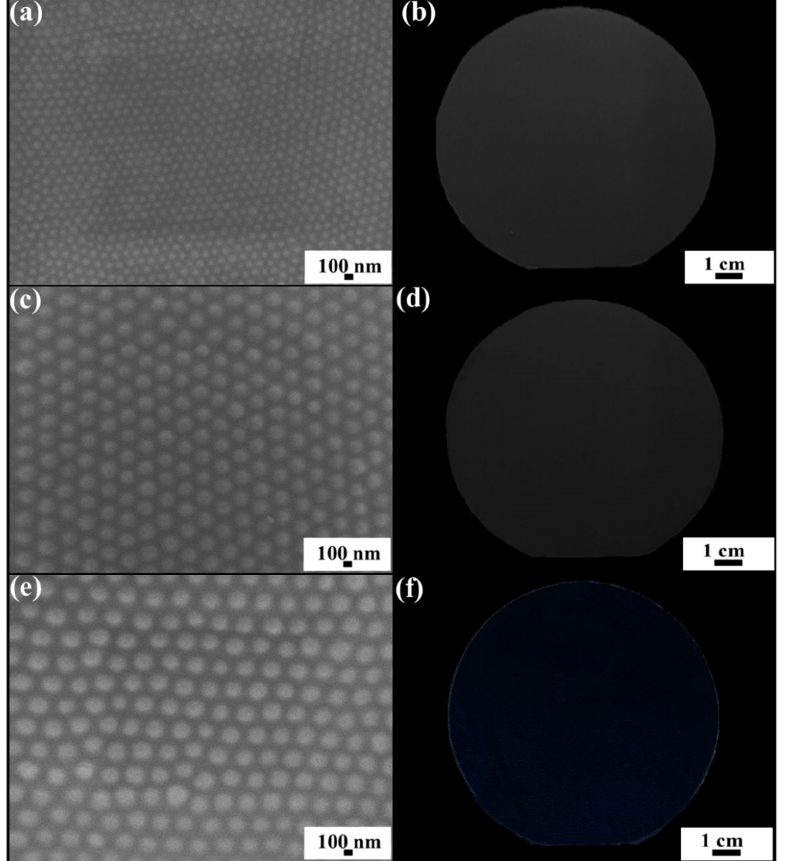
Figure 1. Top-view SEM images and photos of PET substrates coated with non-close-packed ( a , b ) 80 nm silica colloidal crystals, ( c , d ) 130 nm silica colloidal crystals, and ( e , f ) 180 nm silica colloidal crystals.